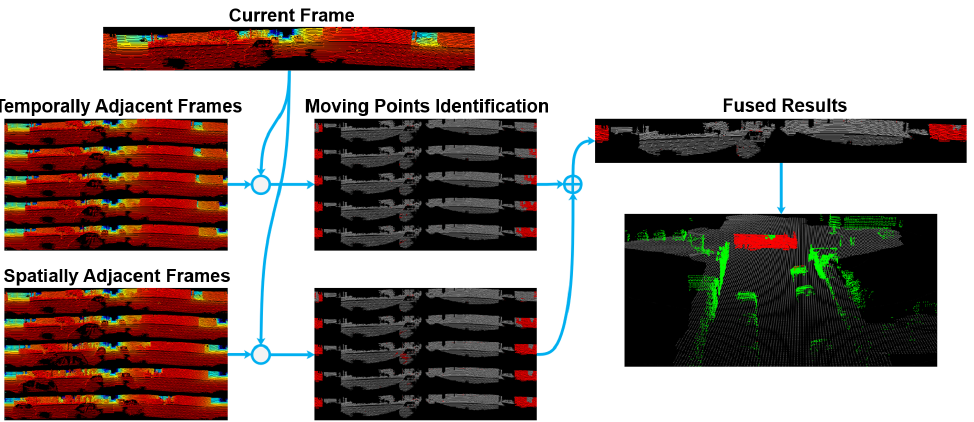
Figure 6. The current frame is compared with each of the five frames in the TAF set and SAF set, respectively. Points that are classified as Case 2 are considered as potential moving points. The 10 comparison results are then fused using a simple counting